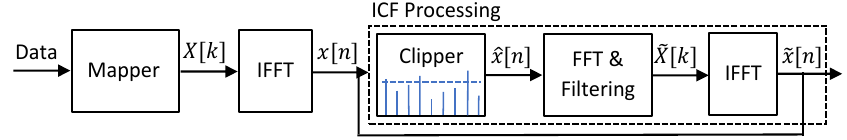
Figure 1. Top-level view of